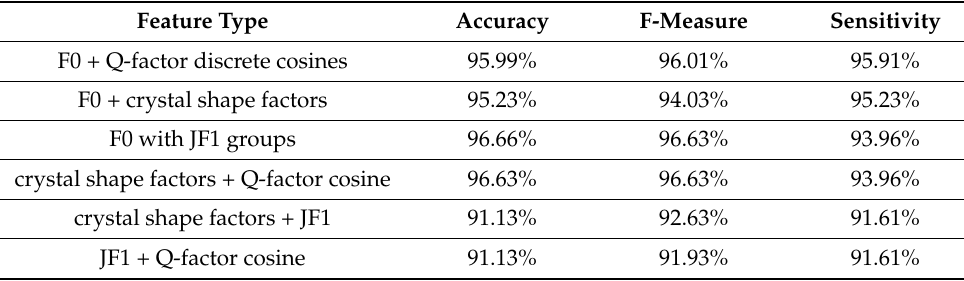
Table 11. Model Joining: Triple Feature Groups for DAE with Fine